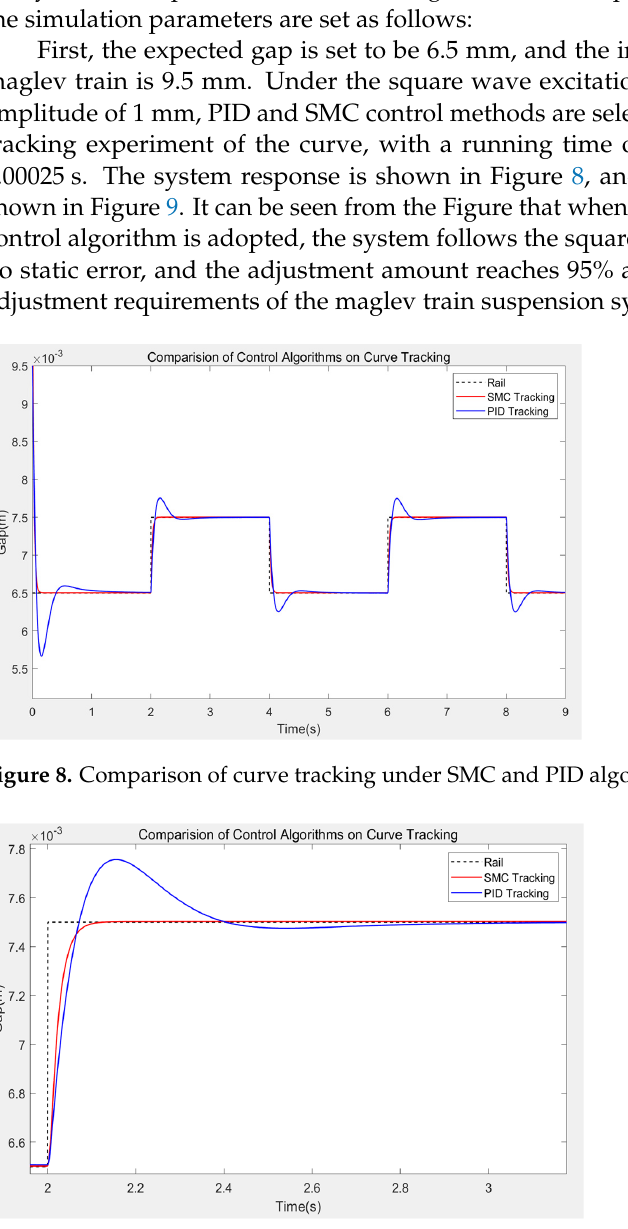
Figure 9. Partial enlarged view of curve tracking.